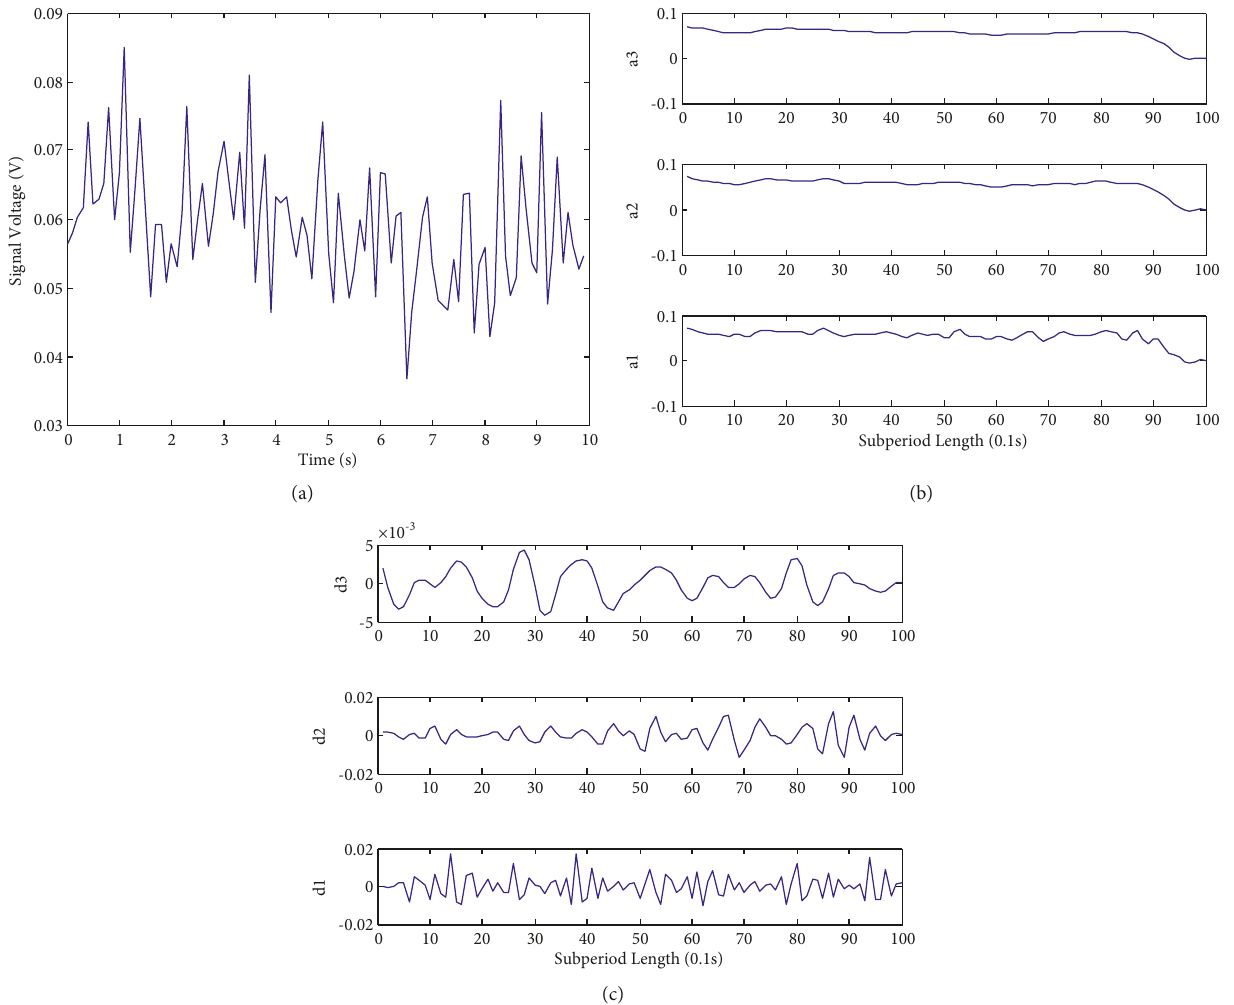
Figure 6: (a) FFT signal with solid to air mass ratio 1.4 and gas flow of 160m 3 /h; (b) wavelet transform approximation signal; (c) wavelet transform detail